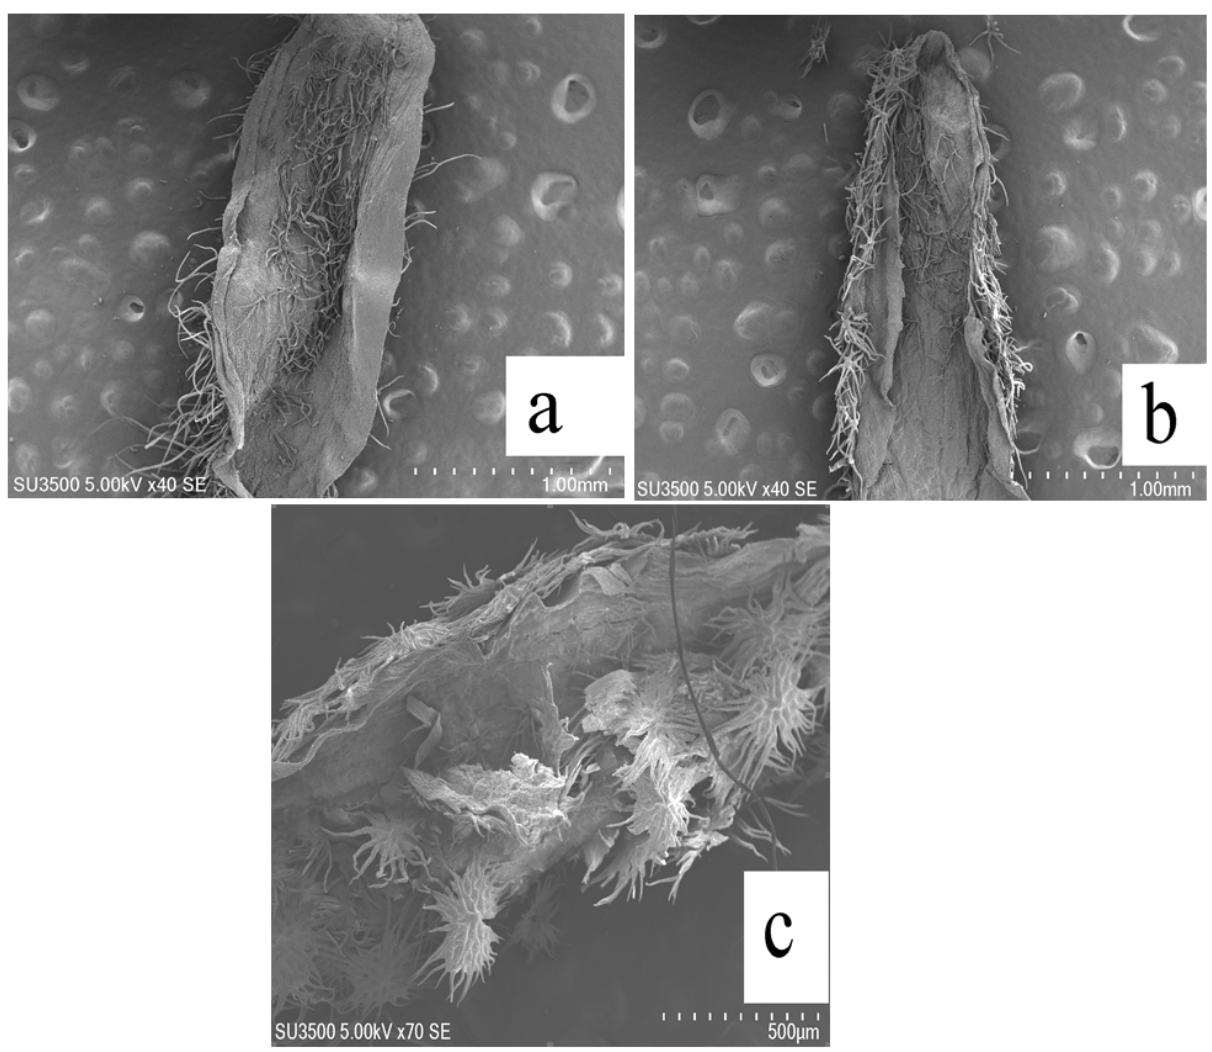
Fig. 2. SEM photo of sepals on the inner surface in type specimens of Alyssum iranicum (A); A. lanceolatum (B); A. persicum